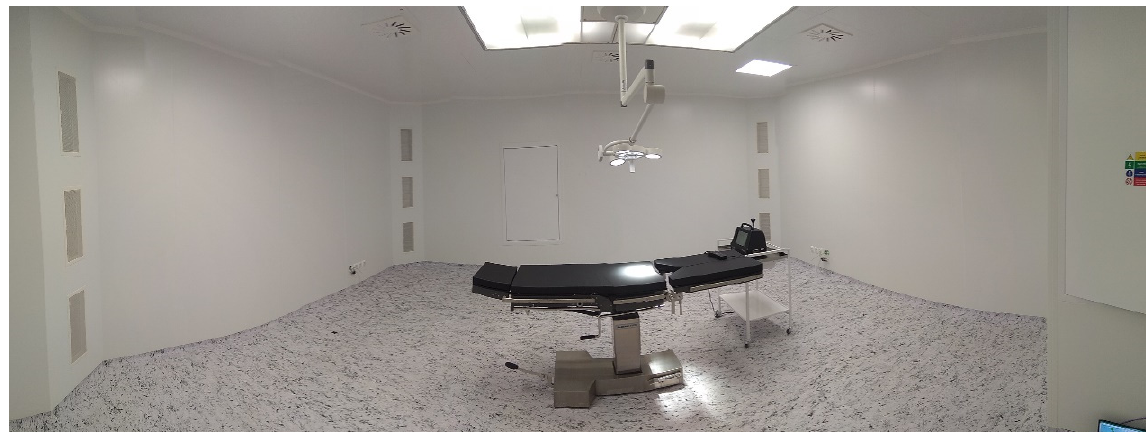
Figure 1. Position of the lamp, staff, and patient in the CFD simulation of the operating room.